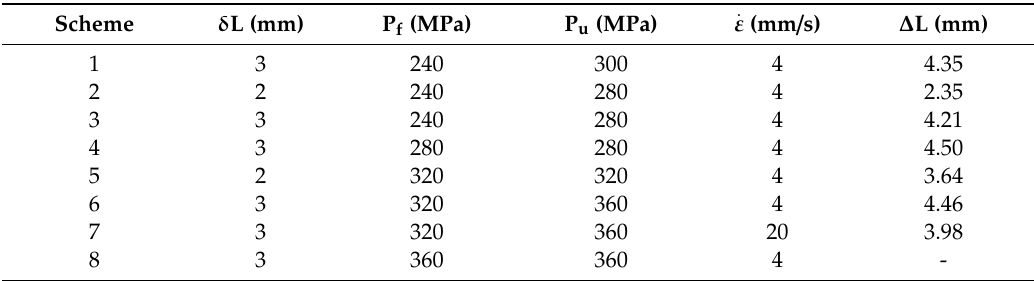
Table 1. Welding parameters used for trial